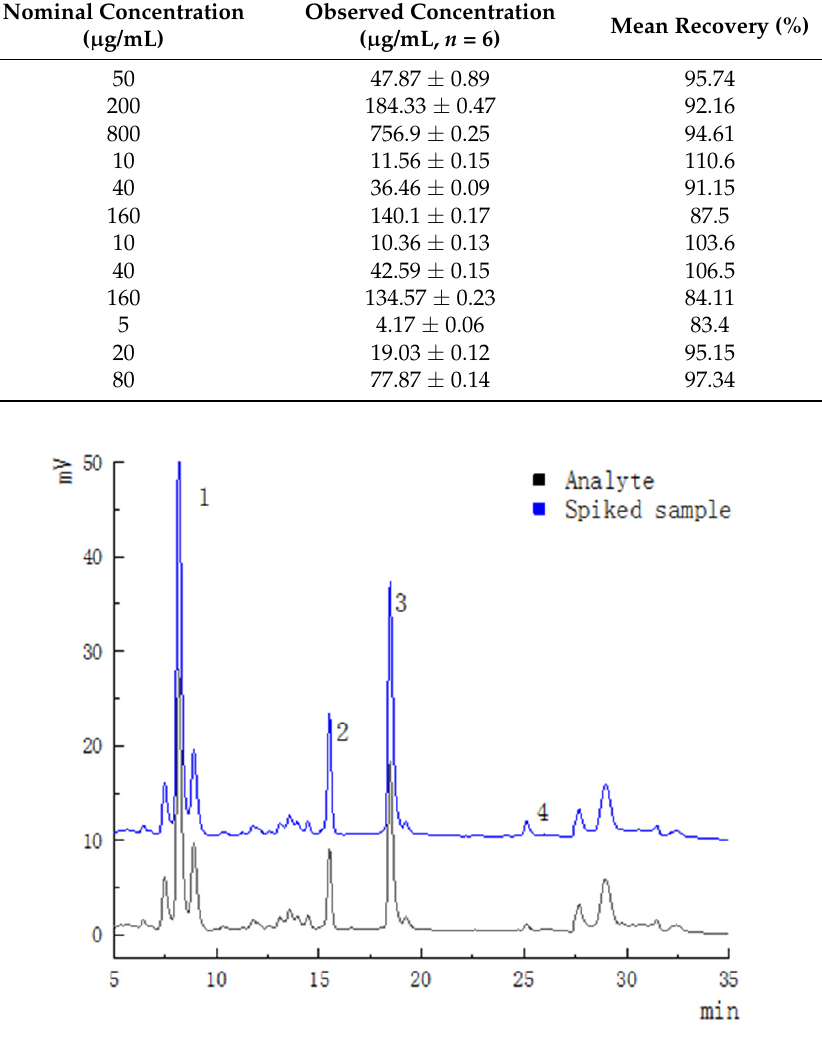
Figure 3. Chromatographic profiles of analytes and spiked sample. 1: Dihydromyricetin; 2: Taxifolin; 3: Myricetin; 4: Quercetin. Table 4. Standard curve equation detection.